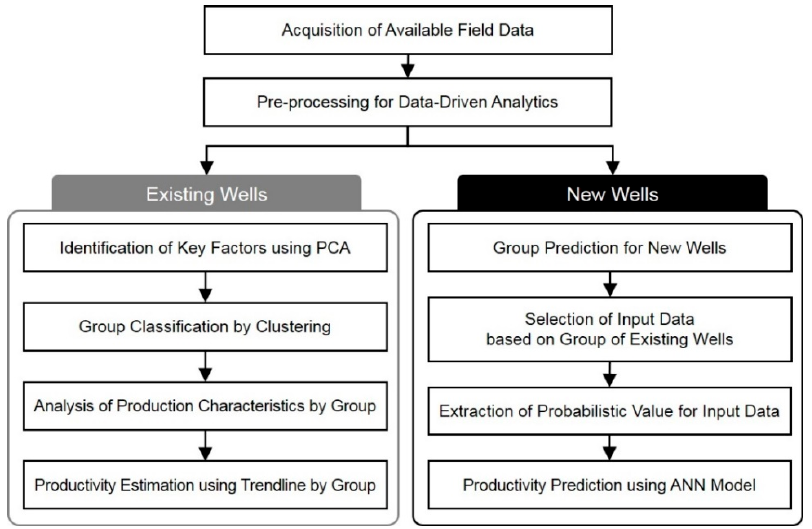
Figure 1. Workflows for predicting productivity from existing and new wells.